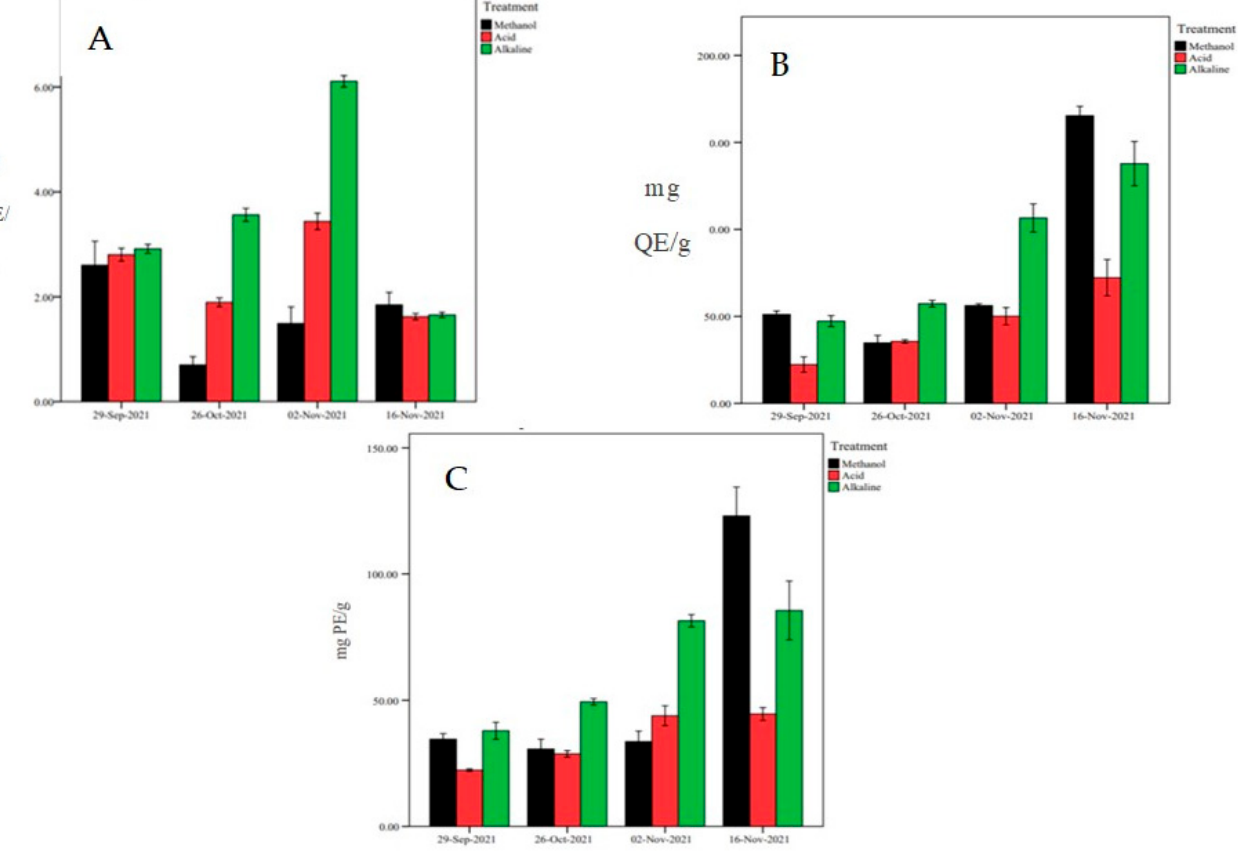
Figure 5. ( A ) Total phenolic content (TPC), ( B ) total flavonoid content (TFC) and ( C ) total ortho -diphenolic content (TdOPC) of four different Bidni cultivars (collected during different dates between September and November) using three different solvent extraction methods—methanol, acid and alkaline (black, red and green bars, respectively) with error bars showing ± 1SD for three independent trails.